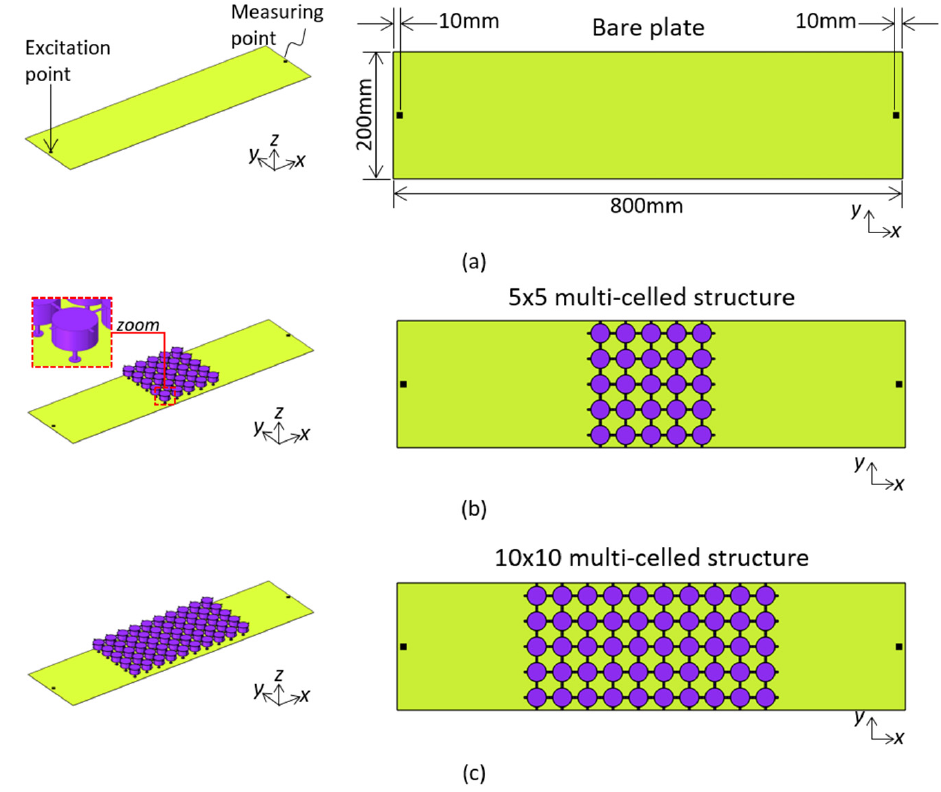
Figure 5. Frequency response analysis of plates ( a ) without and with interconnected metamaterials of sizes ( b ) 5 × 10 and ( c ) 10 × 10.